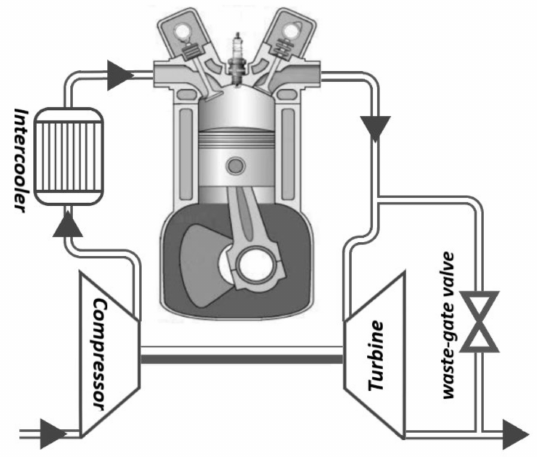
Figure 9. Scheme adopted for the reference turbocharged